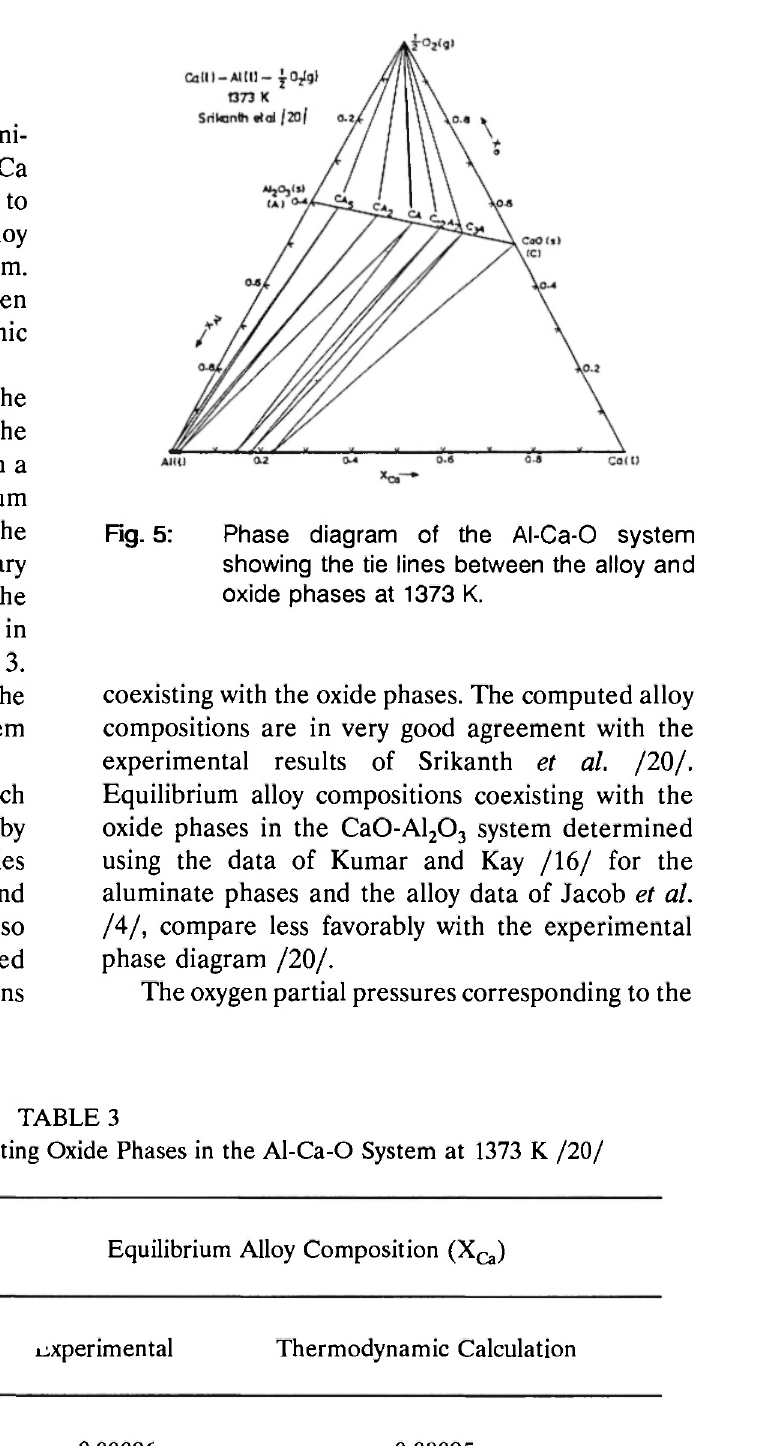
Coexisting Oxide Phases experimental Thermodynamic